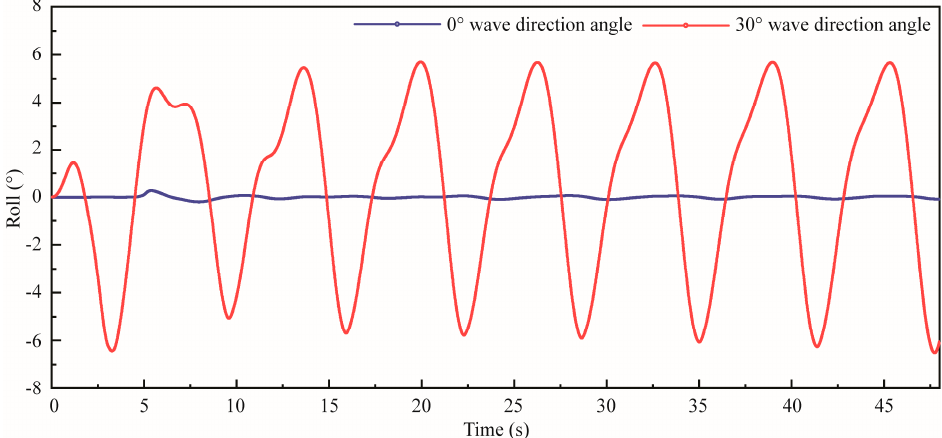
Figure 15. The roll motion with different wave direction angles at 7 level sea state.